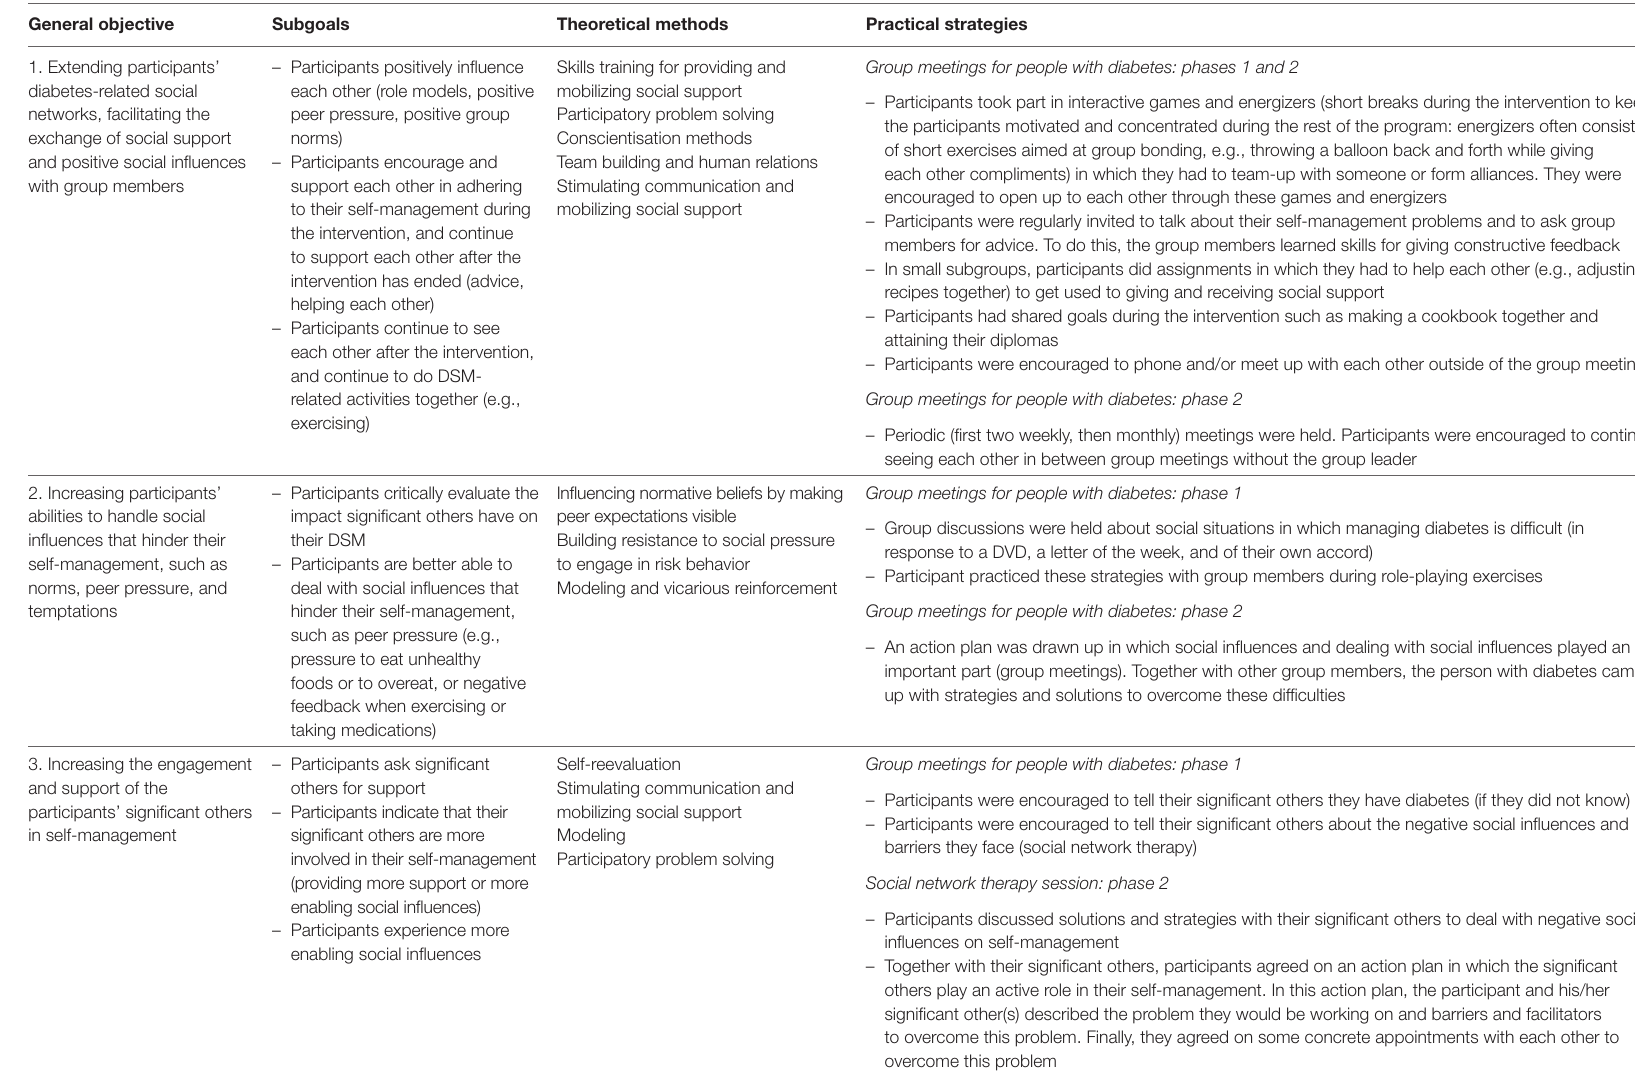
TaBle 12 | Theoretical methods and practical